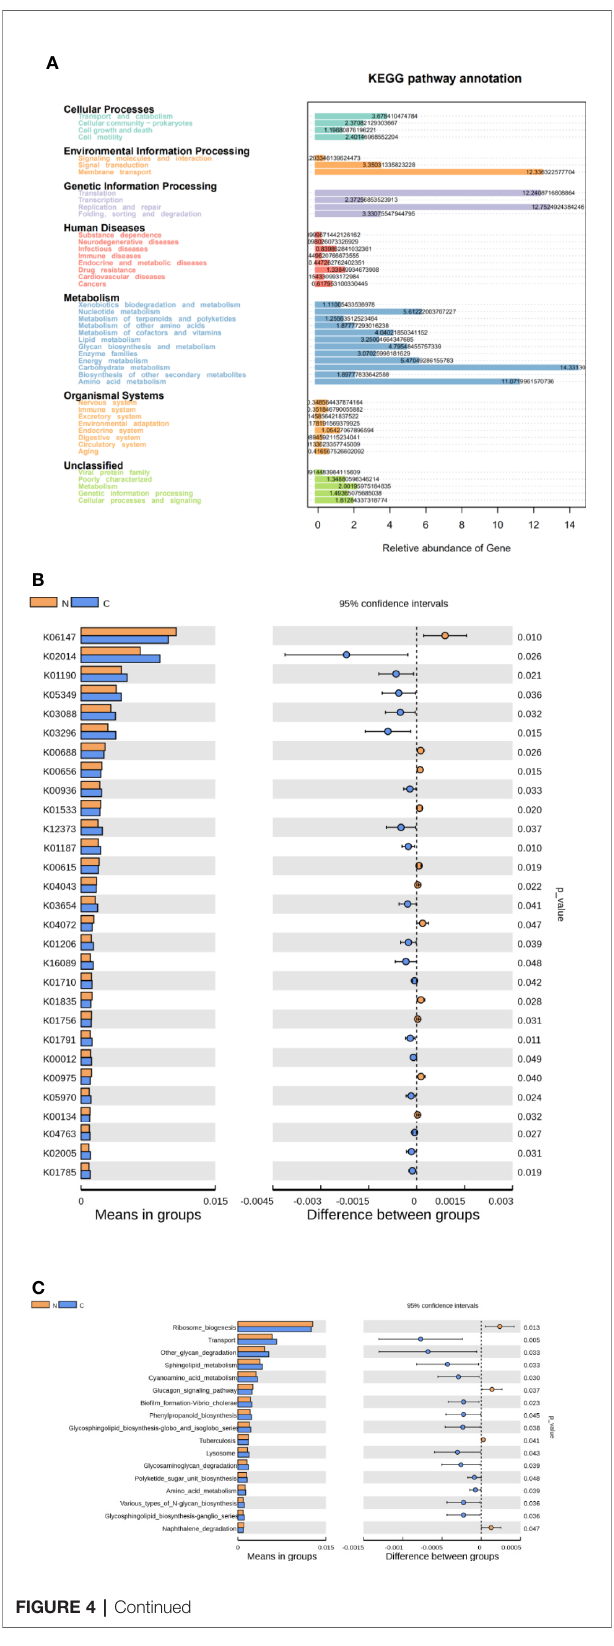
FIGURE 4 | Functional predictions for the fecal microbiome in constipated women of reproductive age and healthy normal controls. (A) The relative abundance of gene in the KEGG pathway. (B) The KOs in the fecal microbiome of the two groups were shown to have signi fi cant differences (p < 0.05), which were identi fi ed using Tax4Fun. (C) The signi fi cant differences (p < 0.05) in KEGG pathways at level 3 for the fecal microbiome